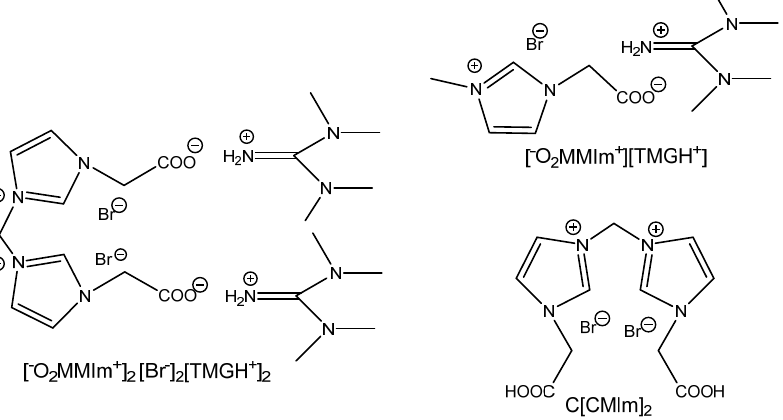
Figure 16. Structures of multifunctional IM-based ILs tested for the carbonation of EPIC [100,101]. The reverse activation of dual amino-functionalized ILs neutralized with acidic aminoacids, such as glutamic or aspartic acids, is possible, as was documented by Yue et al. [102]. This ion-pair-based catalytic system produces, however, high yields at 0.5 MPa and a temperature of 105 °C after 13 h of CO 2 action. It is recyclable without loss of activity and works well in the case of terminal epoxides [102] (Figure 17).